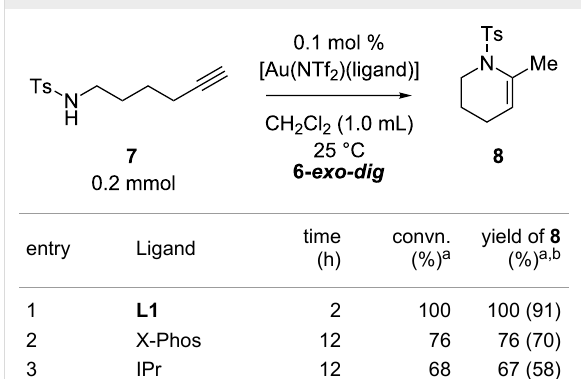
Table 5: 6- exo-dig cyclization of sulfonamide 7